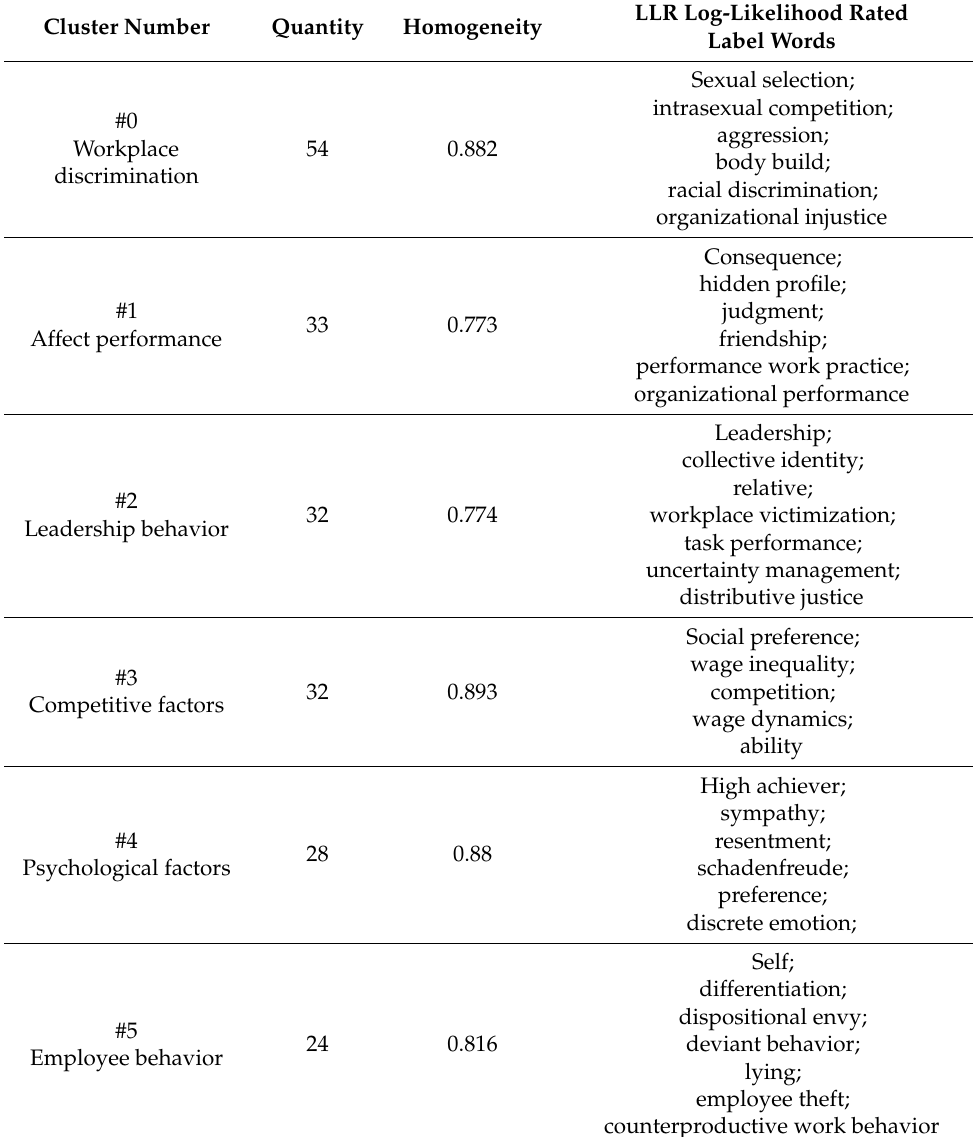
Table 7. The main clustering of documents based on the Loglikelihood ratio (LLR)